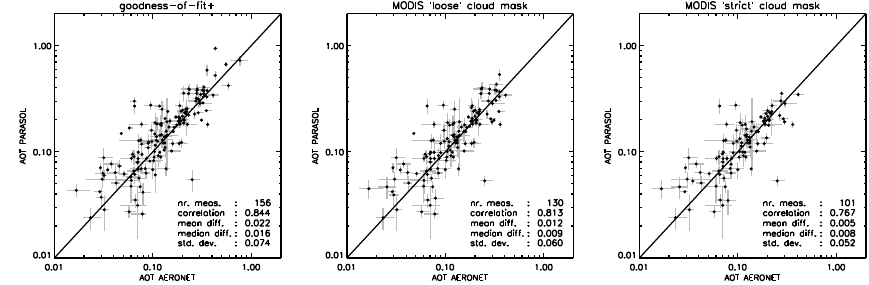
Figure 10. Same as Fig. 9 but for the medium-resolution PARASOL retrievals. The black line shows the 1 : 1